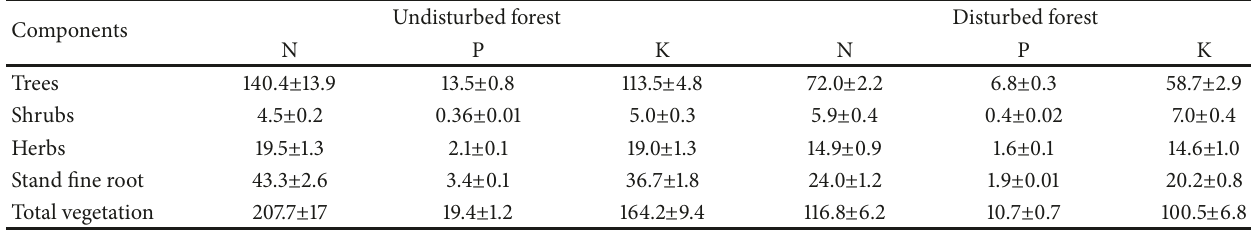
Table 6: Net uptake of nutrients (kg ha – 1 y – 1 ) after adjustment for re-translocation in tree, shrub, herb, and fine root in undisturbed and disturbed forest stands of moist tropical forest of Sunsari district, eastern Nepal (mean ± SE).